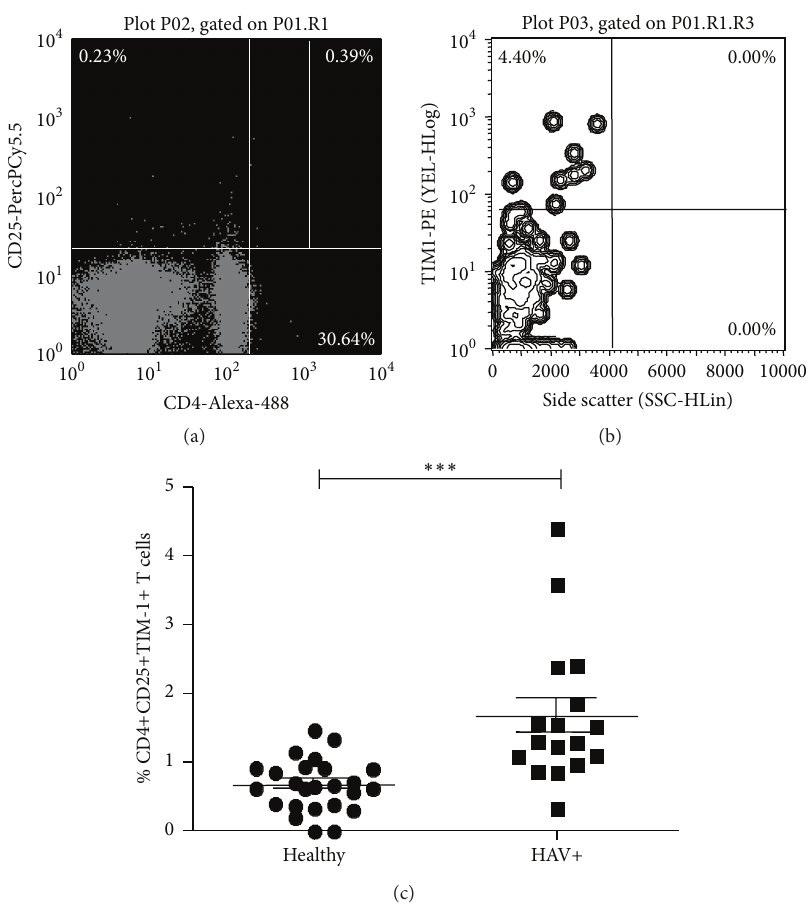
Figure 6: HAV infection leads to an increase in the relative proportion of TIM-1 receptor on CD4+CD25+ TLs. PBLCs from HAV+ pediatric patients were stained with anti-CD4-Alexa 488, anti-CD25-PerCP and anti-TIM1-PE antibodies and evaluated by using flow cytometry. (a) Representative dot plot of CD4+CD25+ staining and selection of the right upper quadrant. (b) Representative dot plot of TIM-1 versus Side Scatter linked to the right upper quadrant on (a), which represents TIM-1 percentage on CD4+CD25+ cells. (c) The results are displayed as the percentage of TIM-1+CD4+CD25+ T cells. The medians and standard deviations from 25 healthy donors and 17 HAV-infected pediatric patients are presented. Nonparametric Mann-Whitney 𝑈 test for comparison between groups was used to calculate statistical significance. 𝑃 < 0.05 was considered statically significant. ∗∗∗ 𝑃 < 0.0001